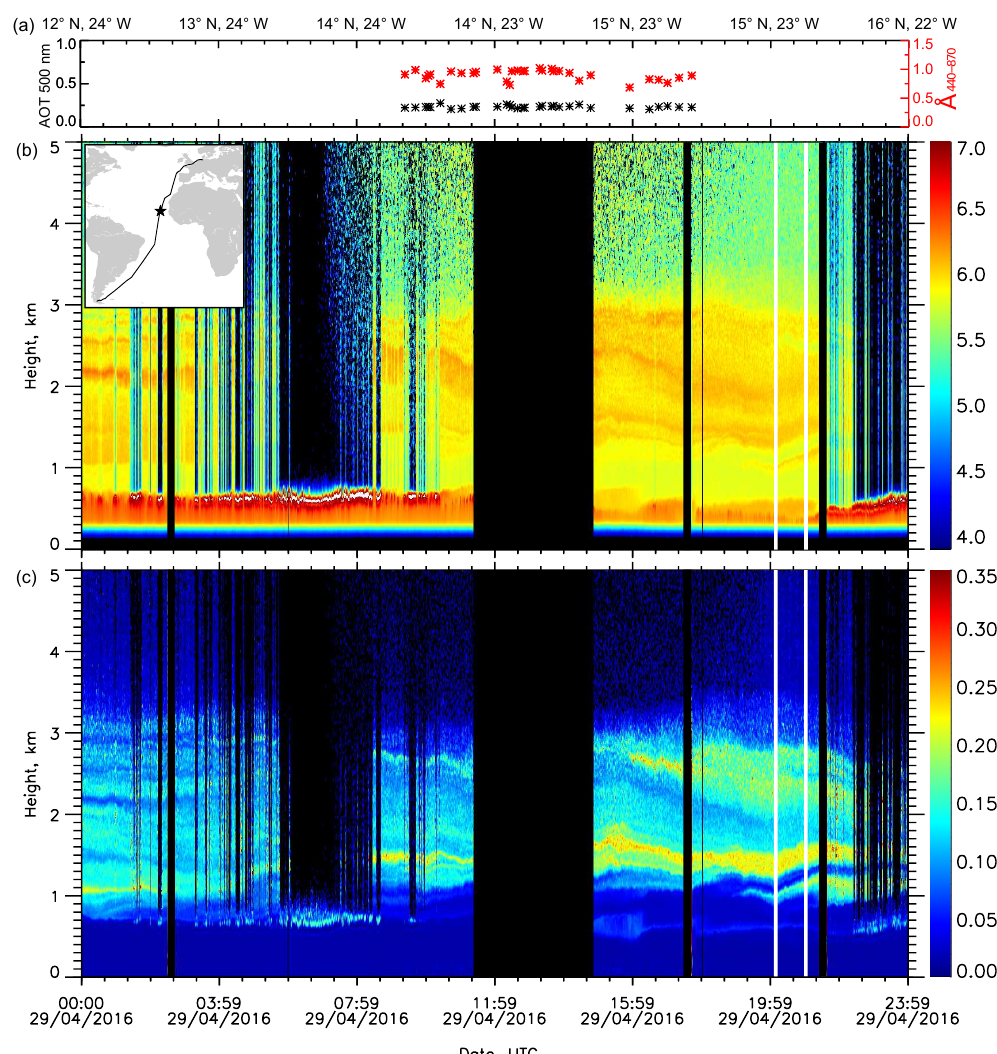
Figure 10. Complex aerosol layering with smoke and dust on PS98: sun-photometer-derived AOT at 500 and 440/870nm Ångström expo- nent (a) , 532nm range-corrected signal (b) , and volume depolarisation ratio (c) . Vertical white lines indicate the signal-averaging period for profiles shown in Fig. 11. The black star in the cruise map shows the location of RV Polarstern during this period.